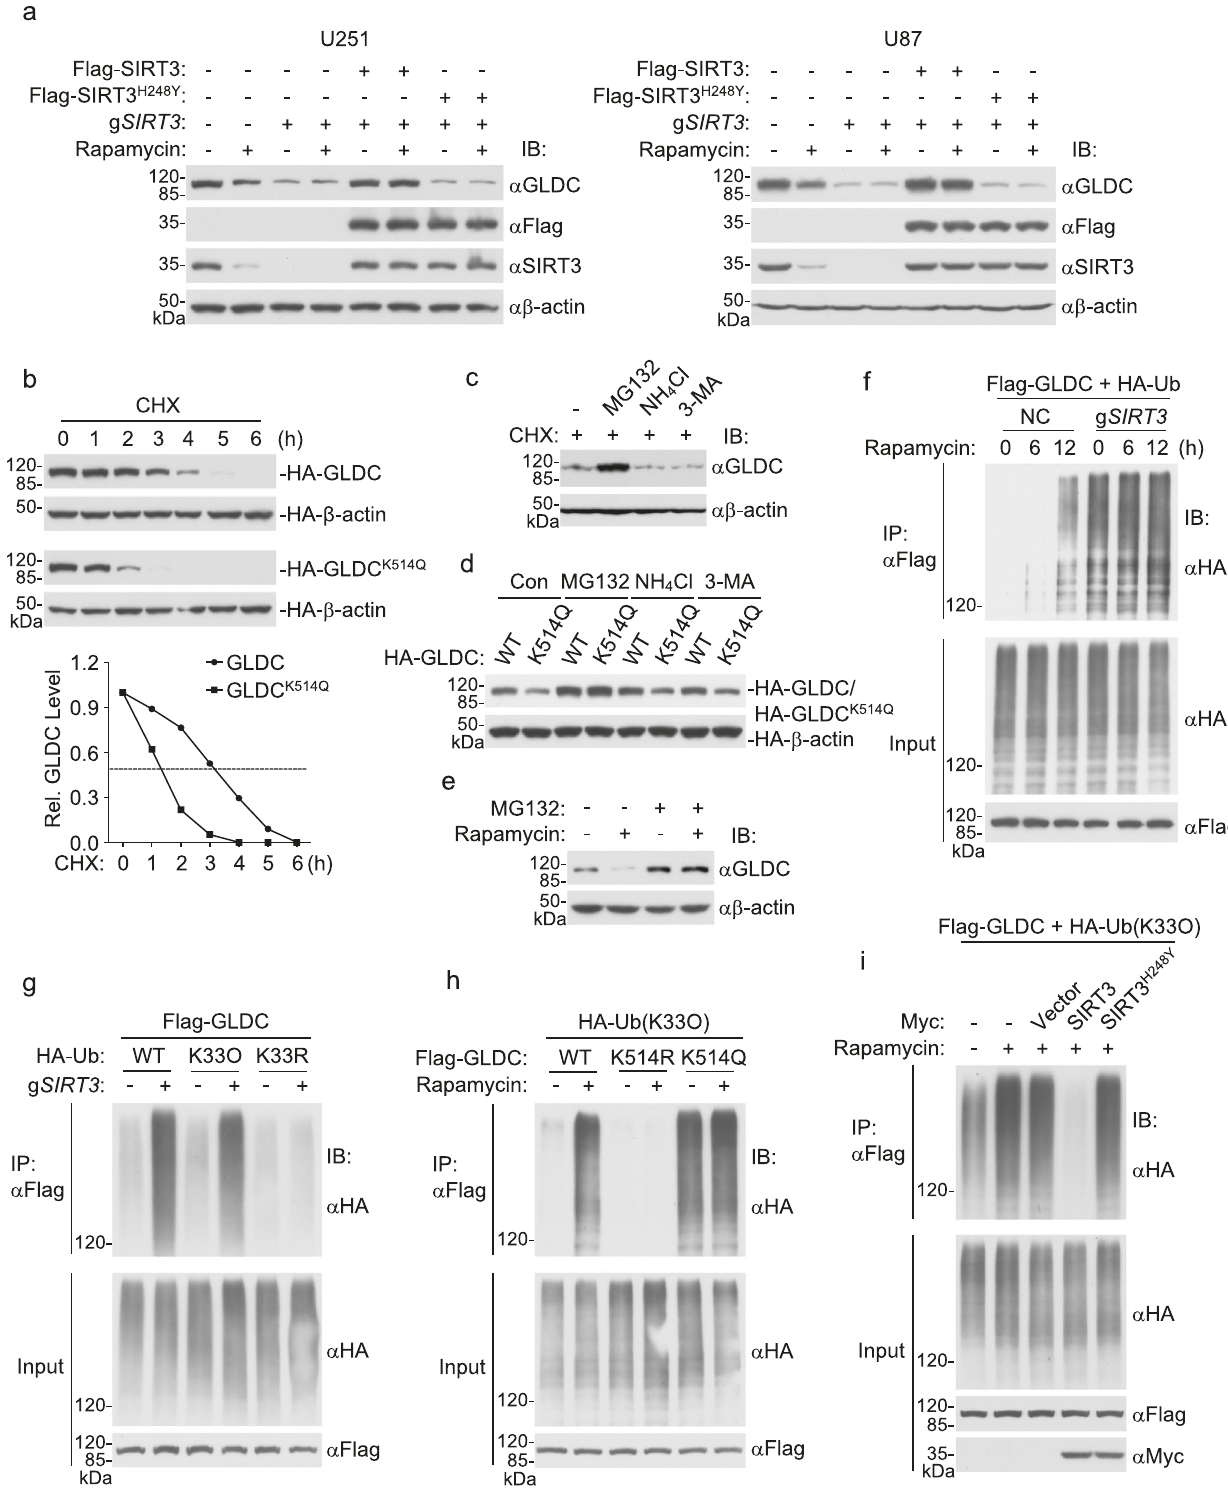
GLDC, SIRT3, and pS6K were positively associated with tumor- igenesis, whereas levels of ACAT1, NF-X1, and GLDC K514 acetylation were negatively associated with tumorigenesis. In conclusion, our fi ndings reveal that GLDC activity is regulated by coordinated posttranslational modi fi cations including acetylation and polyubiquitination, and this contributes to regulation of glycine metabolism and tumorigenesis. Thus, targeting of GLDC